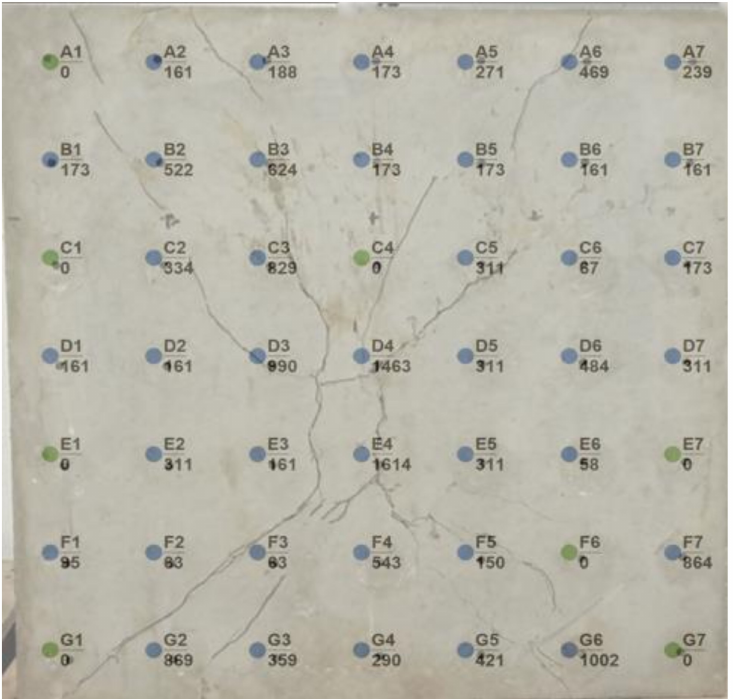
Figure 13. Schema of differences in measured velocities [m · s − 1 ] of ultrasound waves for specimen A2_3 before and after blast load of 600 g TNT: acceleration (red color)–no point; no change (green color)–8 points; deceleration (blue color)–41